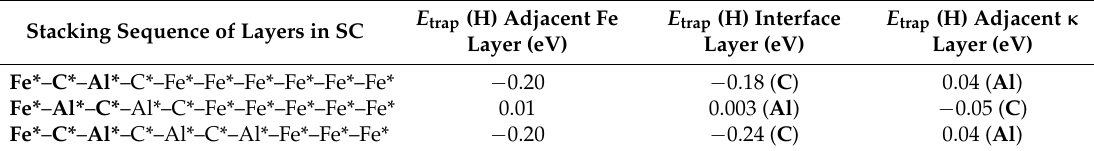
Table 2. Hydrogen trapping energies E trap for octahedral sites at the interface layer between κ -carbide and fcc-Fe, or one of the adjacent layers. Three kinds of stacking sequences in a 2 × 2 × 5 supercell (SC) are provided, where layers used for H incorporation are highlighted in bold face.